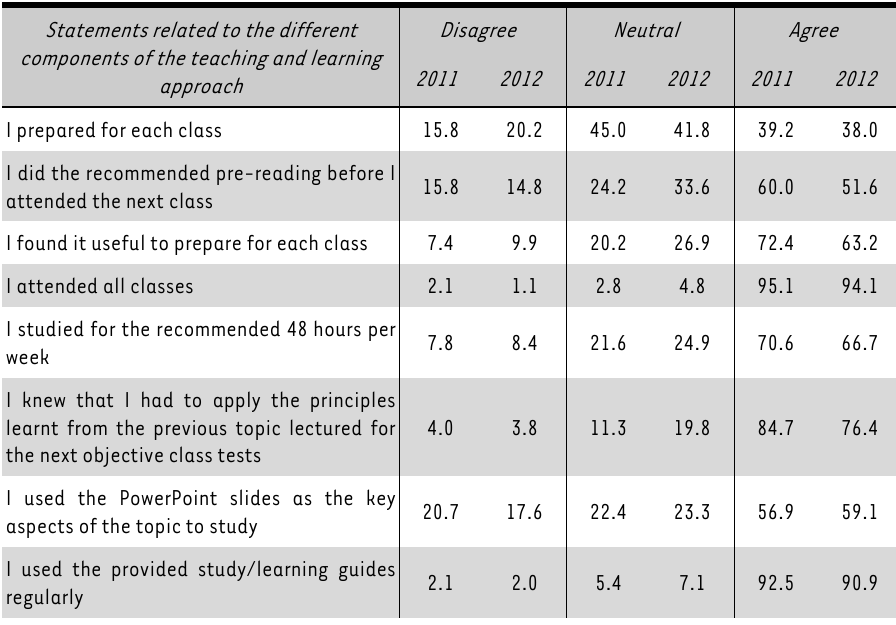
Students’ experiences of the teaching and learning approach Statements related to the different components of the teaching and